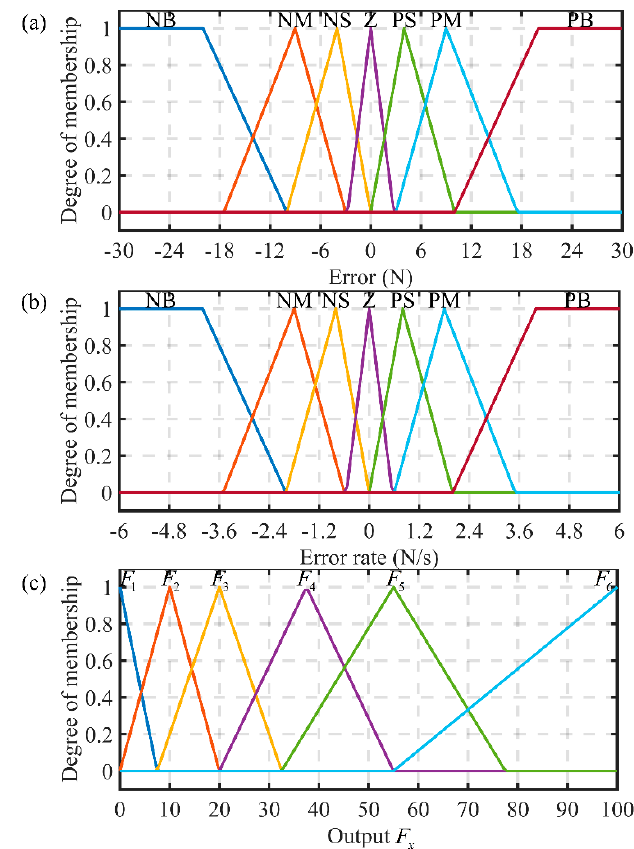
Figure 12. Membership functions of the fuzzy logic controller: ( a ) Input variable error; ( b ) Input variable error rate; ( c ) Output variable. negative big (NB), negative medium (NM), negative small (NS), zero (Z), positive small (PS), positive medium (PM), and positive big (PB).